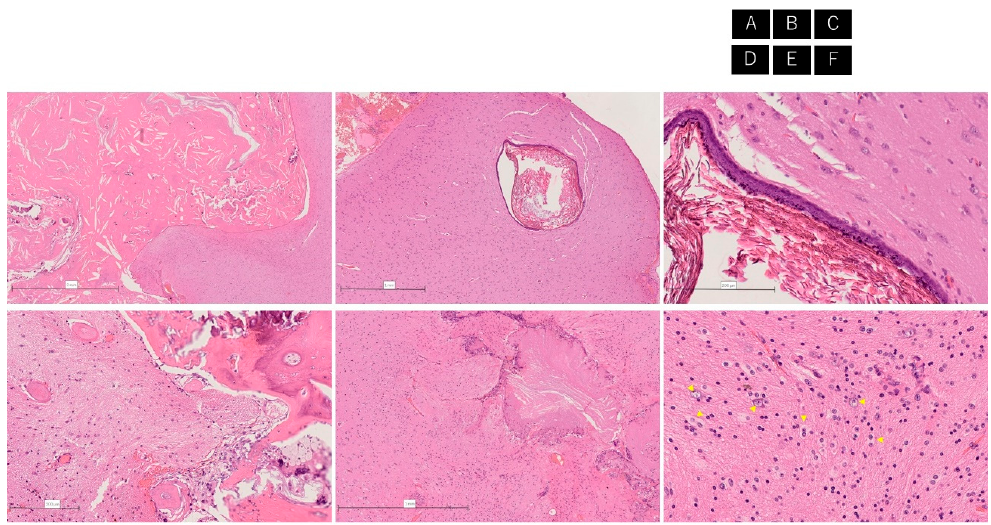
Figure 3. The massive cystic lesion depicted on MRI contains keratinaceous debris ( A ). In the brain parenchyma, other small cystic structures are apparent ( B ). These small cystic structures have an epithelial lining of keratinized, stratified squamous epithelium and are seen in the cortex ( C ). Some parts of the cyst epithelium contain bone components ( D ). Hairs are also seen adjacent to the bone components and in the brain parenchyma ( D ). The keratinized substance is present in a form that is involved in brain parenchyma, and surrounding glial cell proliferation is observed ( E ). Near the keratinized substance, many dysmorphic neurons (representative neurons; yellow arrowhead) are situated in the white matter. The neurons range from normal-sized to enlarged and show cytologic atypia such as abnormalities of nuclear shape, size, or nucleolar morphology, indicative of focal cortical dysplasia ( F ).